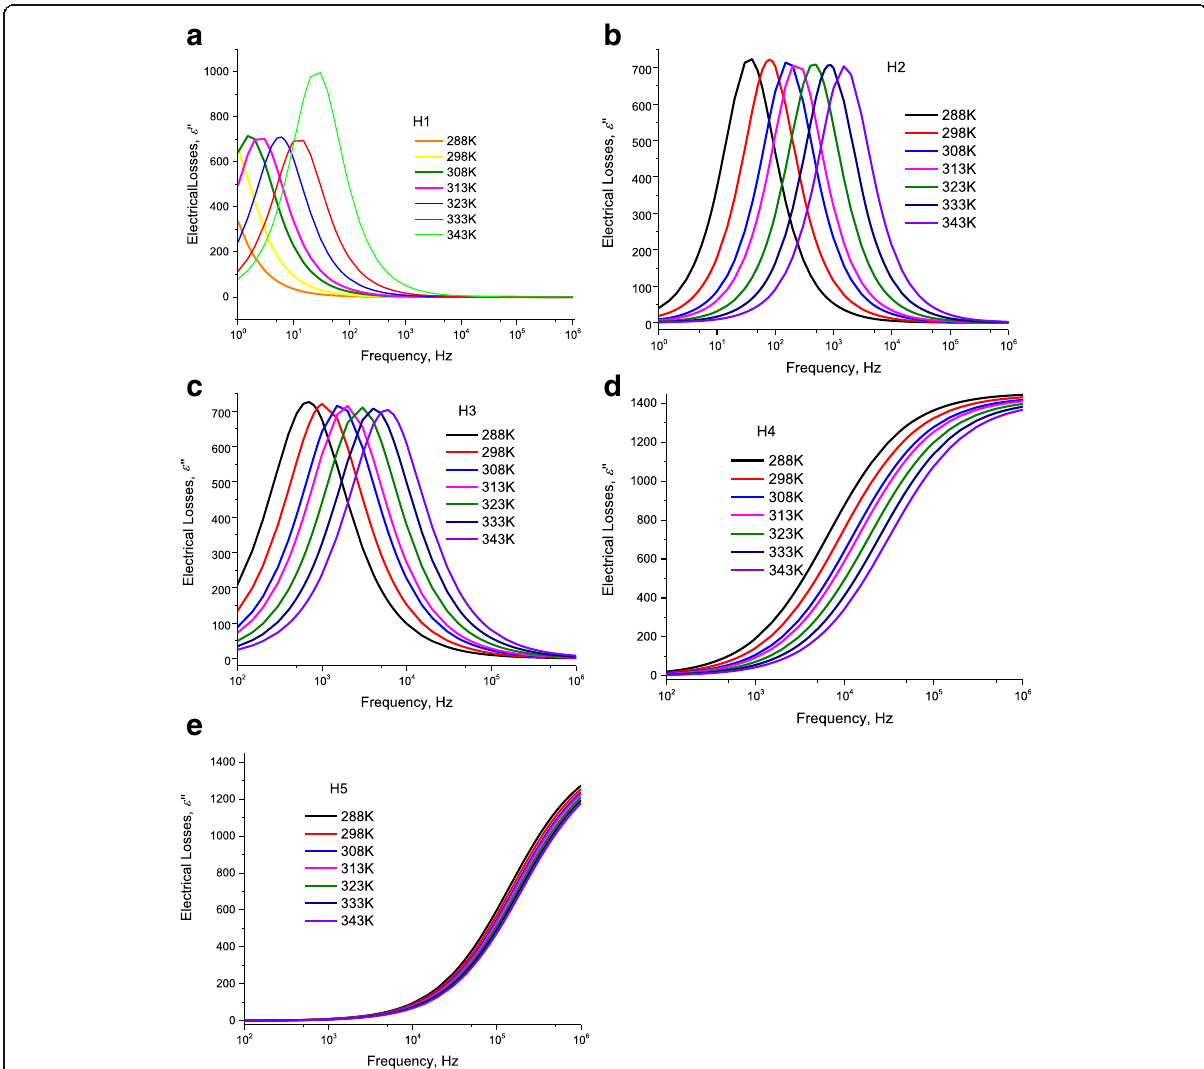
Fig. 17 a Electric losses as a function of frequency calculated after AC-conductivity through DNA molecule for different temperature humps (H1). Lines represent calculated values after Eq. (12) with the data in Figs. 8 and 9. b Electric losses as a function of frequency calculated after AC-conductivity through DNA molecule for different temperature humps (H2). Lines represent calculated values after Eq. (12) with the data in Figs. 8 and 9. c Electric losses as a function of frequency calculated after AC-conductivity through DNA molecule for different temperature humps (H3). Lines represent calculated values after Eq. (12) with the data in Figs. 8 and 9. d Electric losses as a function of frequency calculated after AC-conductivity through DNA molecule for different temperature humps (H4). Lines represent calculated values after Eq. (2) with the data in Figs. 8 and 9. e Electric losses as a function of frequency calculated after AC-conductivity through DNA molecule for different temperature humps (H5). Lines represent calculated values after Eq. (12) with the data in Figs. 8 and